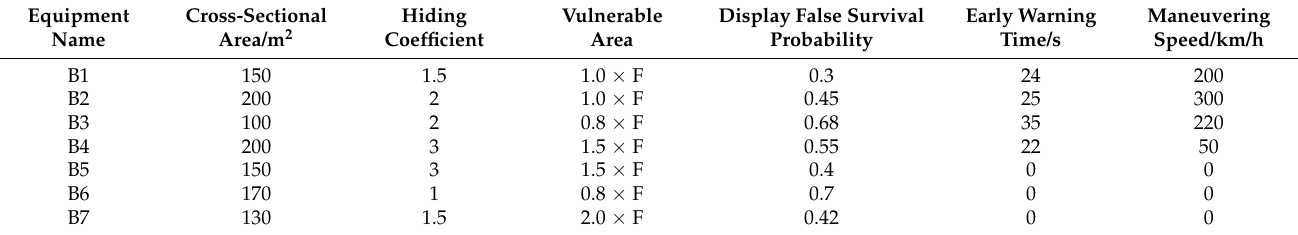
Table 8. Communication distance of the red side’s equipment.